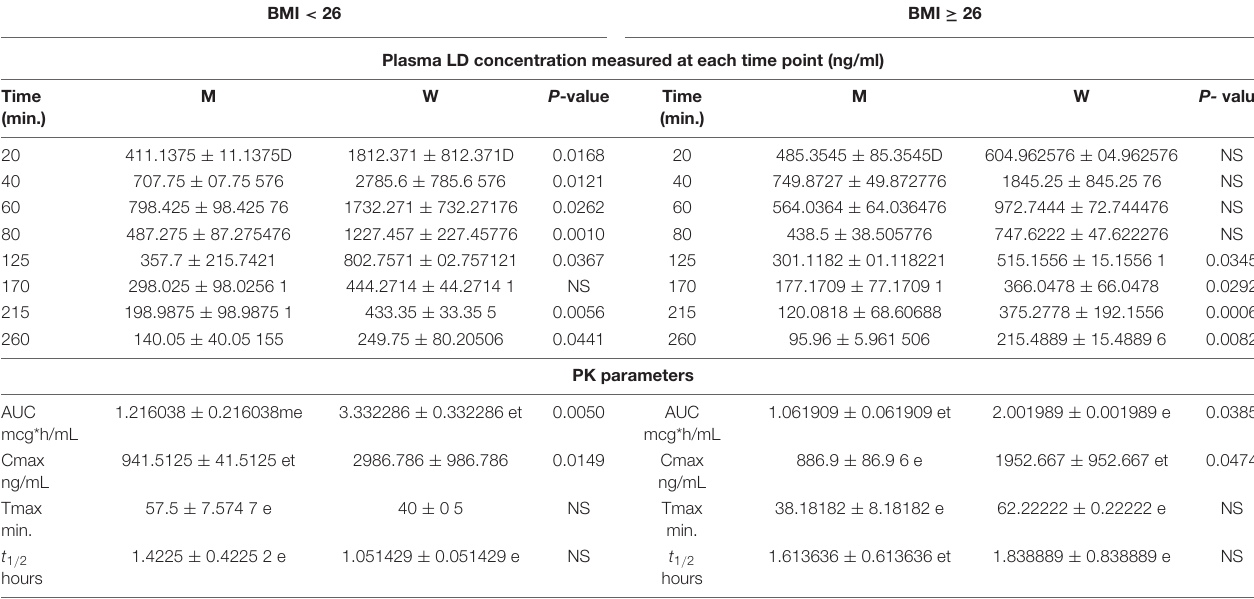
TABLE 3 | Differences in plasma LD concentrations and PK parameters between men and women stratified by the BMI median value. BMI < 26 BMI ≥ 26 Plasma LD concentration measured at each time point (ng/ml) Time